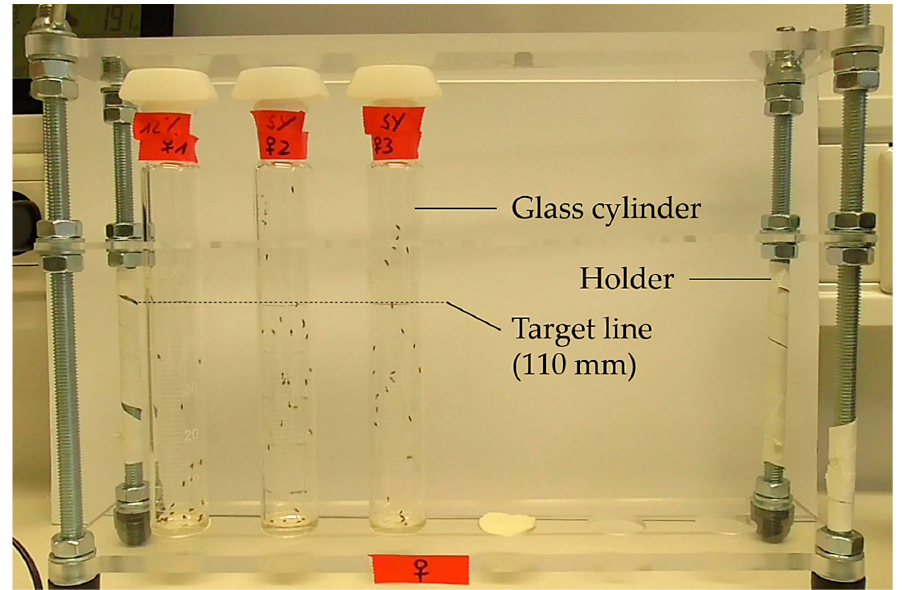
Figure 8. Rapid iterative negative geotaxis (RING) assay. A defined number of flies are inserted into empty vials or cylinders with a target line (marked here at 110 mm). The vials or cylinders are fixed in a holder (RING apparatus). After a short adaptation time, the RING apparatus is tapped on the table until all flies are on the bottom of the vials, and a photograph capturing all vials is taken. The process of tapping and photographing is repeated 10 times at 1-min intervals. Alternatively, a video of the climbing process is recorded. These photographs or video recordings are used to determine the climbing ability of the flies (modified from [83]).